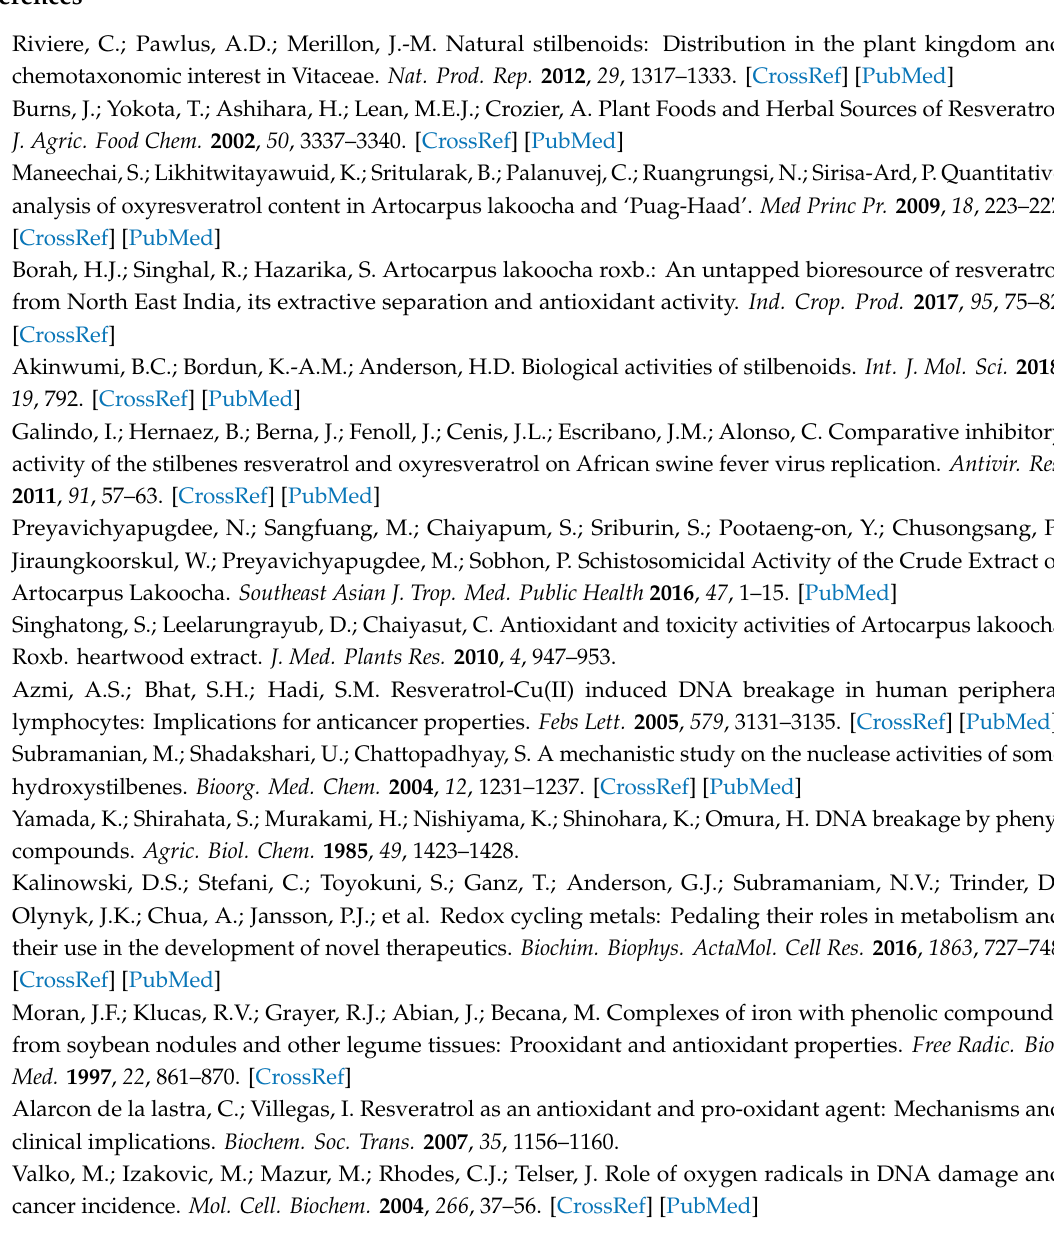
Supplementary Materials: The following are available online, Figure S1: 1 H-NMR Oxyresveratrol, Figure S2: 13 C-NMR Oxyresveratrol, Figure S3: ESI-MS spectrum of standard oxyresveratrol, Figure S4: ESI-MS spectrum of the peak RT 14.0 in the water extract, Figure S5: ESI-MS spectrum of the peak RT 14.0 in the ethanol extract, Figure S6: ESI-MS spectrum of the peak RT 14.0 in the ethyl acetate